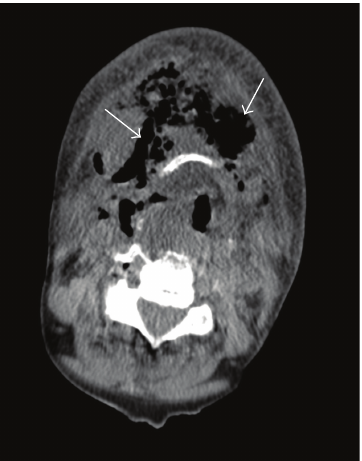
Figure 2: Axial CT image of patient preoperatively at level of hyoid. Note again presence of gas in anterior cervical space and stranding of fat suggestive of acute